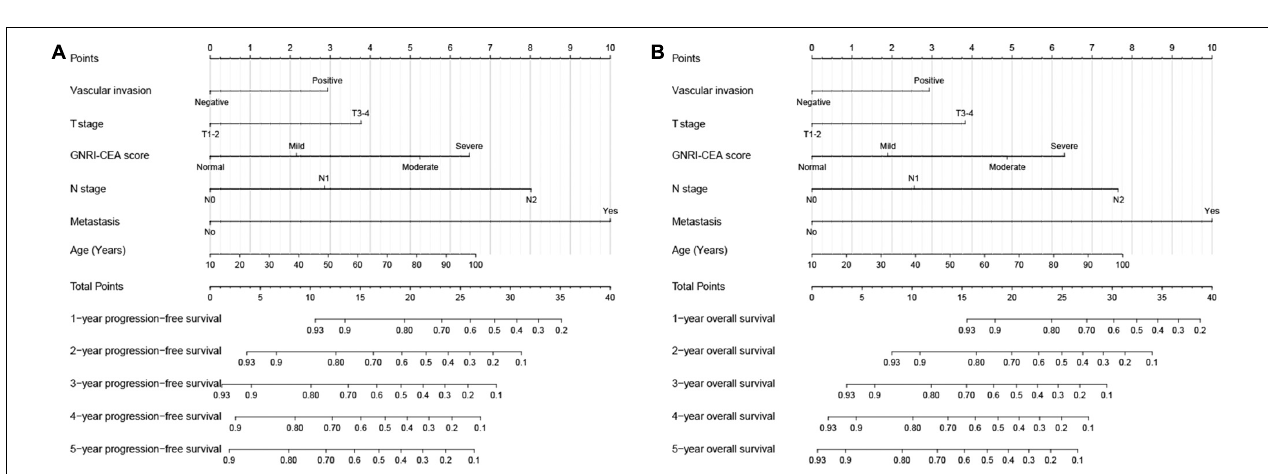
(0.683–0.763) and 0.740 (0.697–0.783), respectively. Calibration curves demonstrated the best agreement between predicted survival probabilities and actual observations in both validation a ( Supplementary Figure 11A ) and validation b ( Supplementary Figure 11B ) groups. In the validation cohorts, the developed